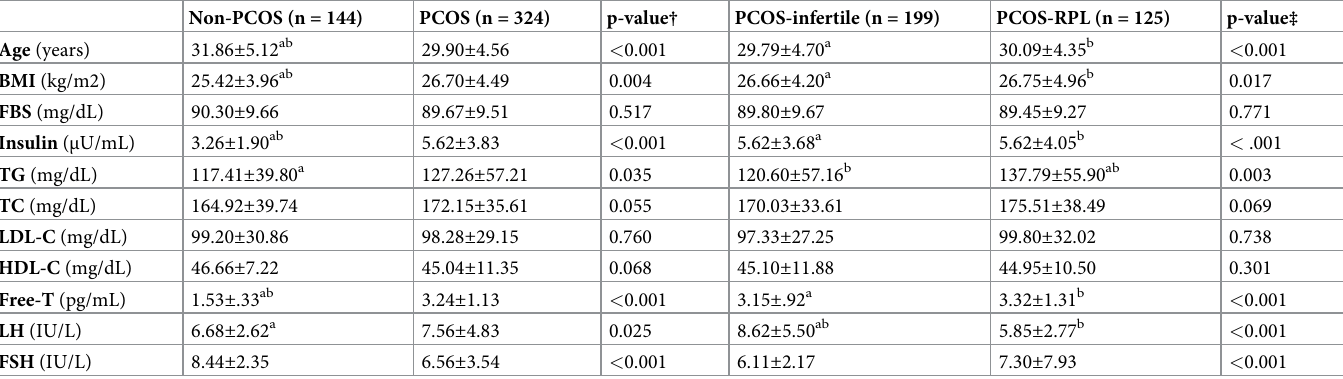
Table 1. Comparison of clinical characteristics between non-PCOS and PCOS